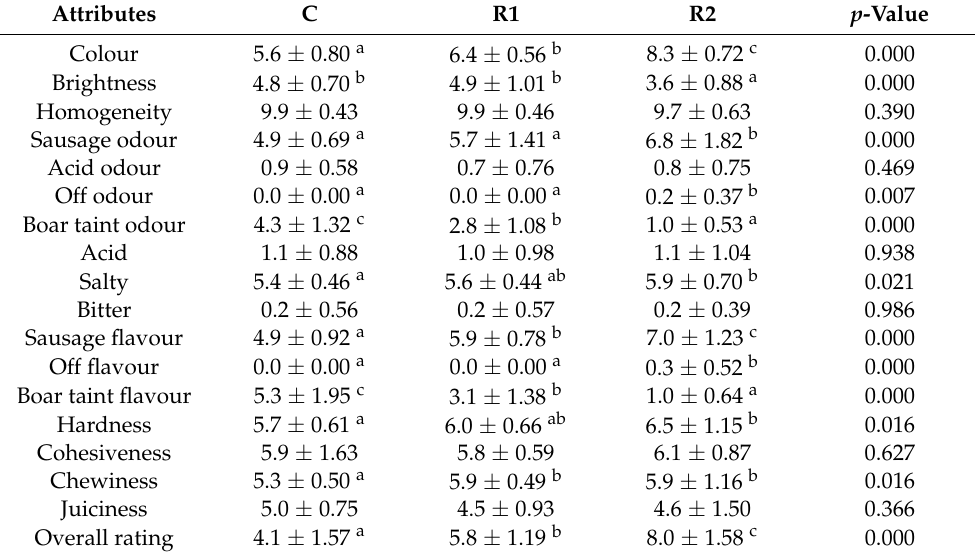
Table 4. Sensory analyses of fuet sausages (means ±